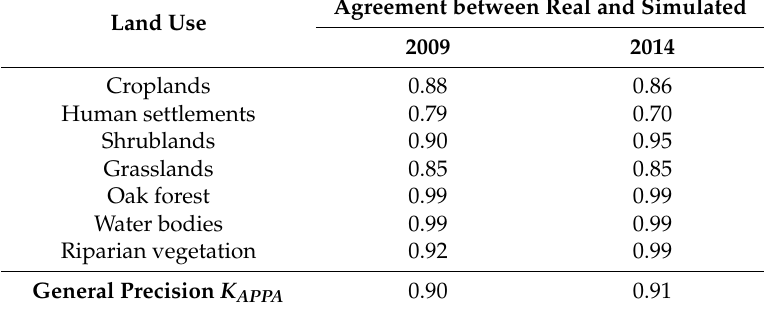
Table 7. Agreement between the real and simulated values of seven land uses of 2009 and 2014 in the urban and peripheral areas of Chihuahua City.